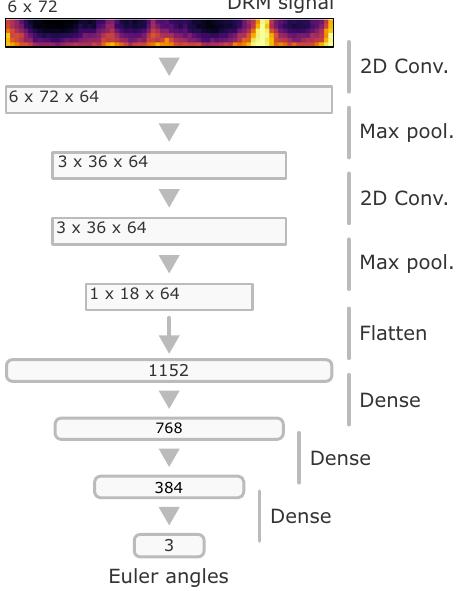
Fig. 4 Convolutional neural network model architecture. Our CNN model, EulerNet, connects the input directional re fl ectance signal to crystal orientation, which is represented as a set of three Euler angles. The input is fi rst passed through convolutional layers and max-pooling layers to extract visual patterns, and then through fully connected regression layers, leading to the Euler angles algorithm based on optical fl ow estimation. We anticipate that, despite selecting pixels at the center of grains for the error evaluation, imperfections in the registration process may still lead to mislabeling of a fraction of the test data (see Supplementary Fig. 2c). The tail of the distribution at high disorientation angles in Fig. 5a likely contains this mislabeled data. Secondly, mounting the specimen for DRM such that the transverse and build